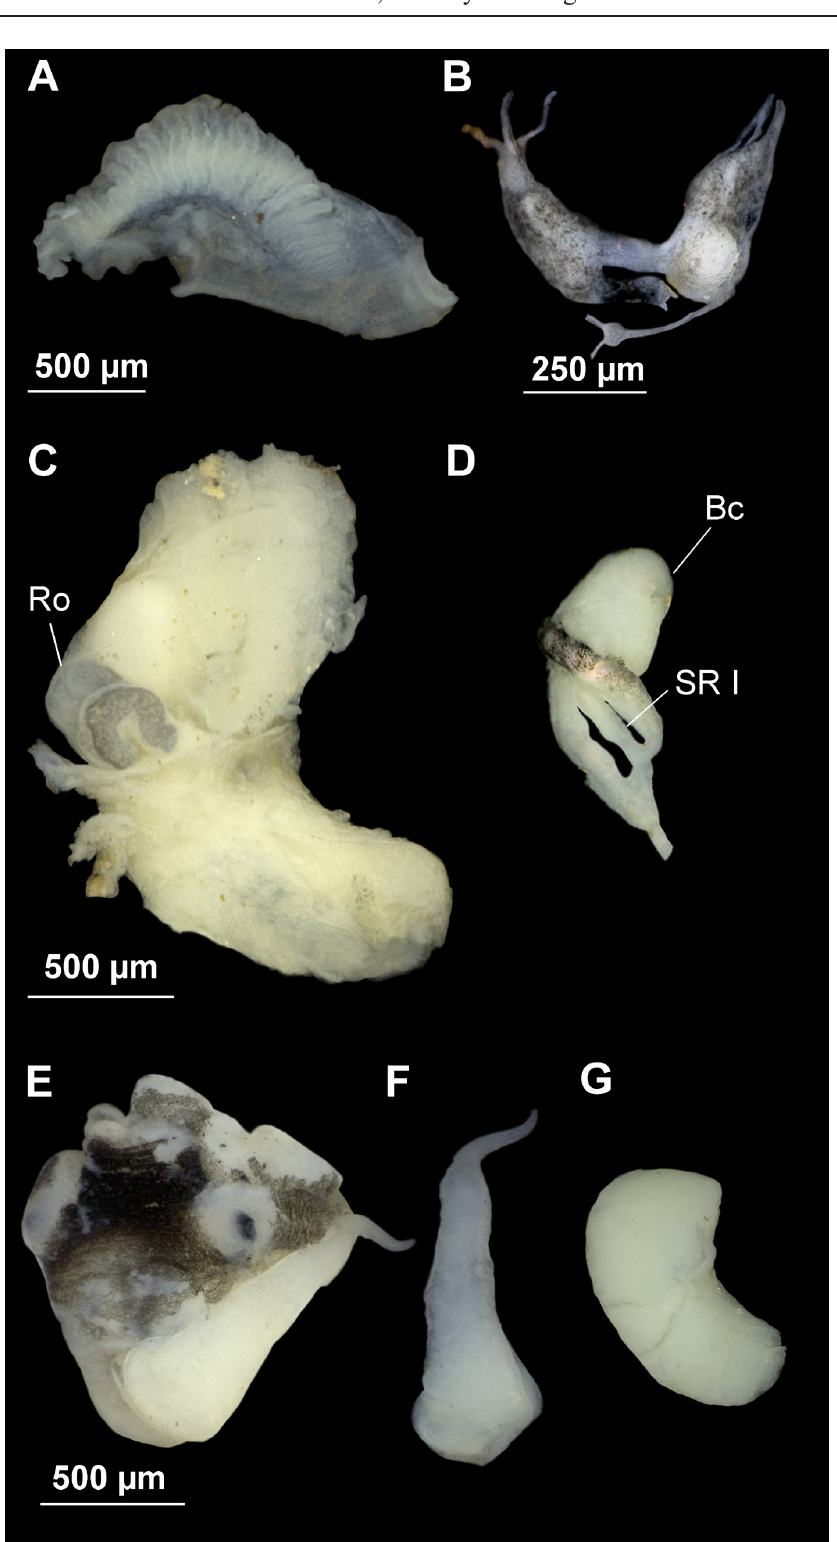
Fig. 3. Anatomy of Intermaria zagrosensis (Glöer & Pešić, 2009) gen. et comb. nov. from Pol Kangarar stream, Kermanshah Province, Iran. A . Ctenidium and osphradium. B . Partial nervous system. C . Female genitalia. D . Bursa copulatrix and seminal receptacle. E–F . Head of a male and penis. G . Prostate gland. Anatomical abbreviations given in the Material and